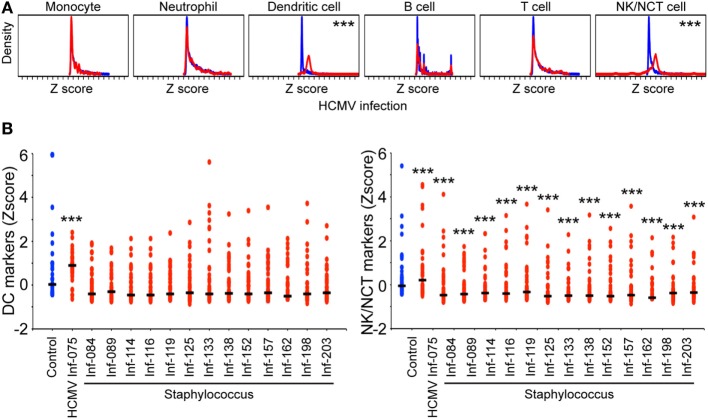
Activated expression of dendritic and natural killer (NK) cell markers upon congenital neonatal human cytomegalovirus (HCMV) infection. The expression of immune cell markers for monocytes, neutrophils, dendritic cell, B cell, T cells, and NK cells was investigated using transcriptomic analysis of whole blood isolated from a congenitally HCMV-infected neonate (n = 1, red) and uninfected neonatal controls (n = 35, blue). Using Wilcoxon Rank Sum test, adjusting for false discovery, a significantly activated expression profile was observed for dendritic cell (p < 1.3e−15) and NK/NCT cell (p < 1.8e−08) markers, but not for markers for monocytes, neutrophils, B, T cells. A p-value < 0.05 was considered significant, with *p < 0.05, **p < 0.01, and ***p < 0.001 (A). The expression of immune cell markers for dendritic cells and NK/NCT cells in uninfected controls (n = 35, blue), one HCMV-infected neonate (n = 1, red) as in (A), and 13 coagulase negative Staphylococcus-infected neonates (n = 13, red). Median expression is depicted as a black horizontal line and p-values < 0.05 were considered significant, with *p < 0.05, **p < 0.01, and ***p < 0.001 (B).